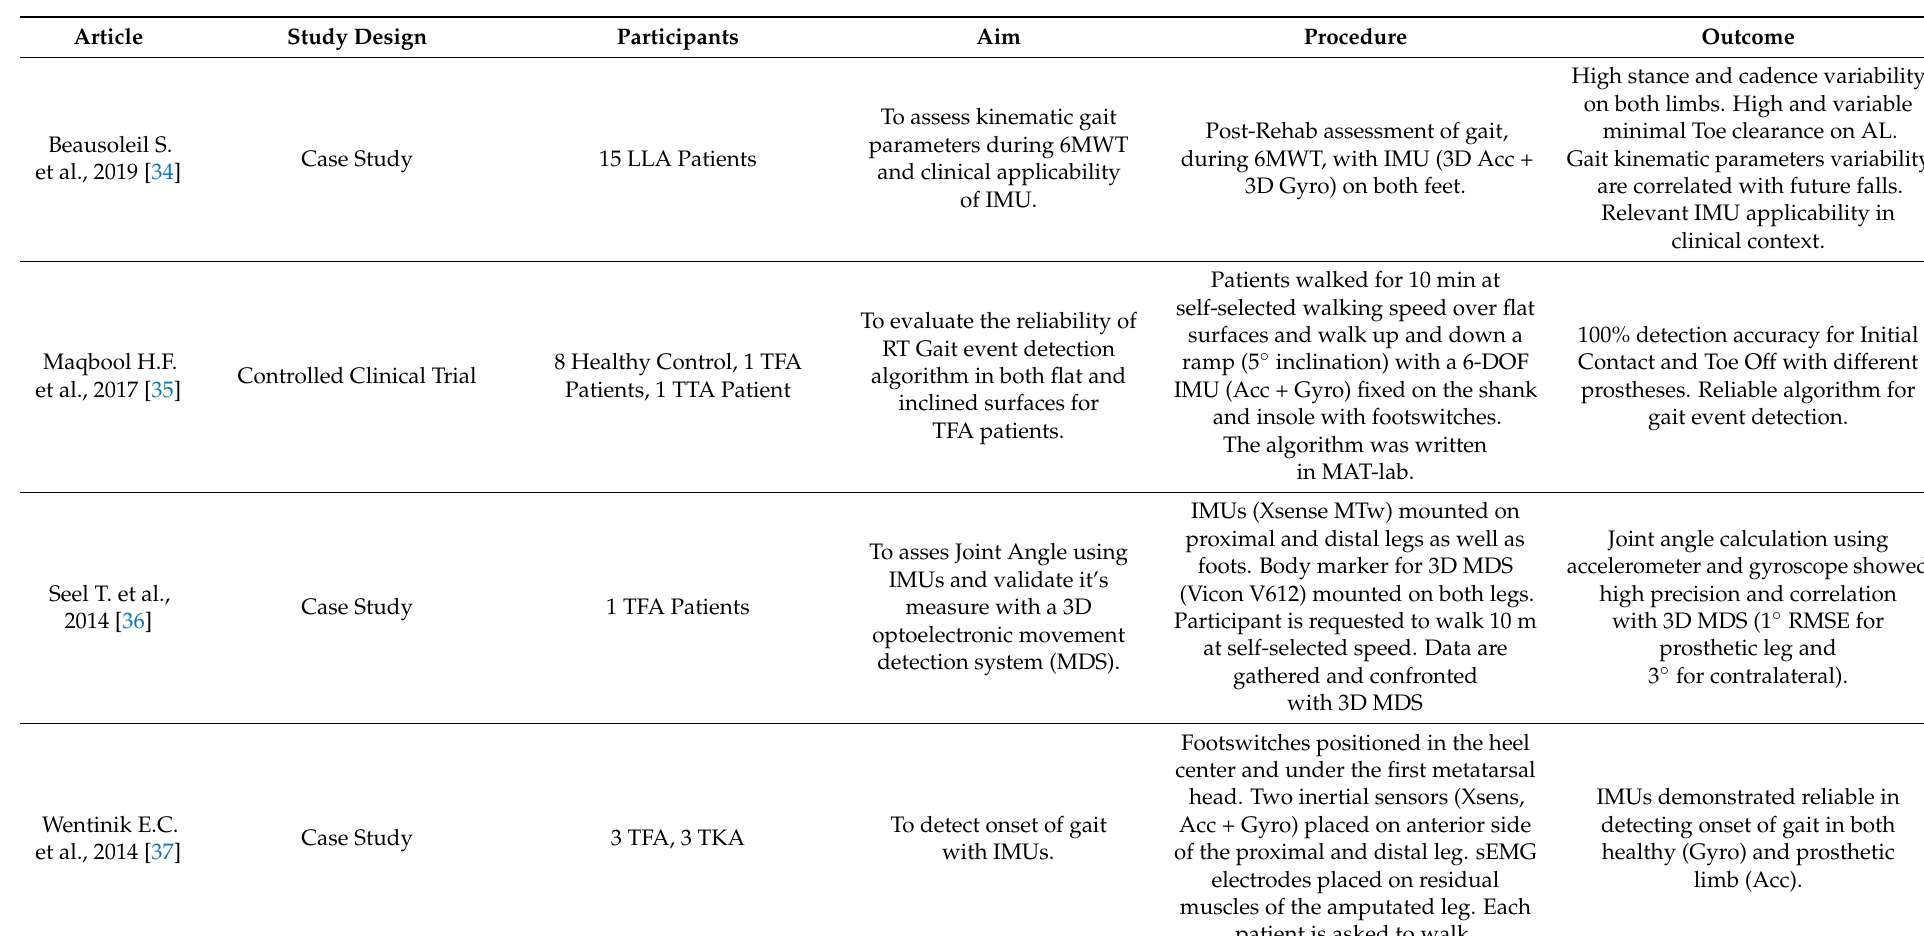
Table 1. Main characteristics of the included studies. LLA (lower limb amputees); ULLA (unilateral lower limb amputees); BiLLA (bilateral lower limb amputees) (TFA (transfemoral amputees); TT (transtibial); TTA (transtibial amputees); BiTTA (bilateralt transtibial amputatees) TKA (through the knee